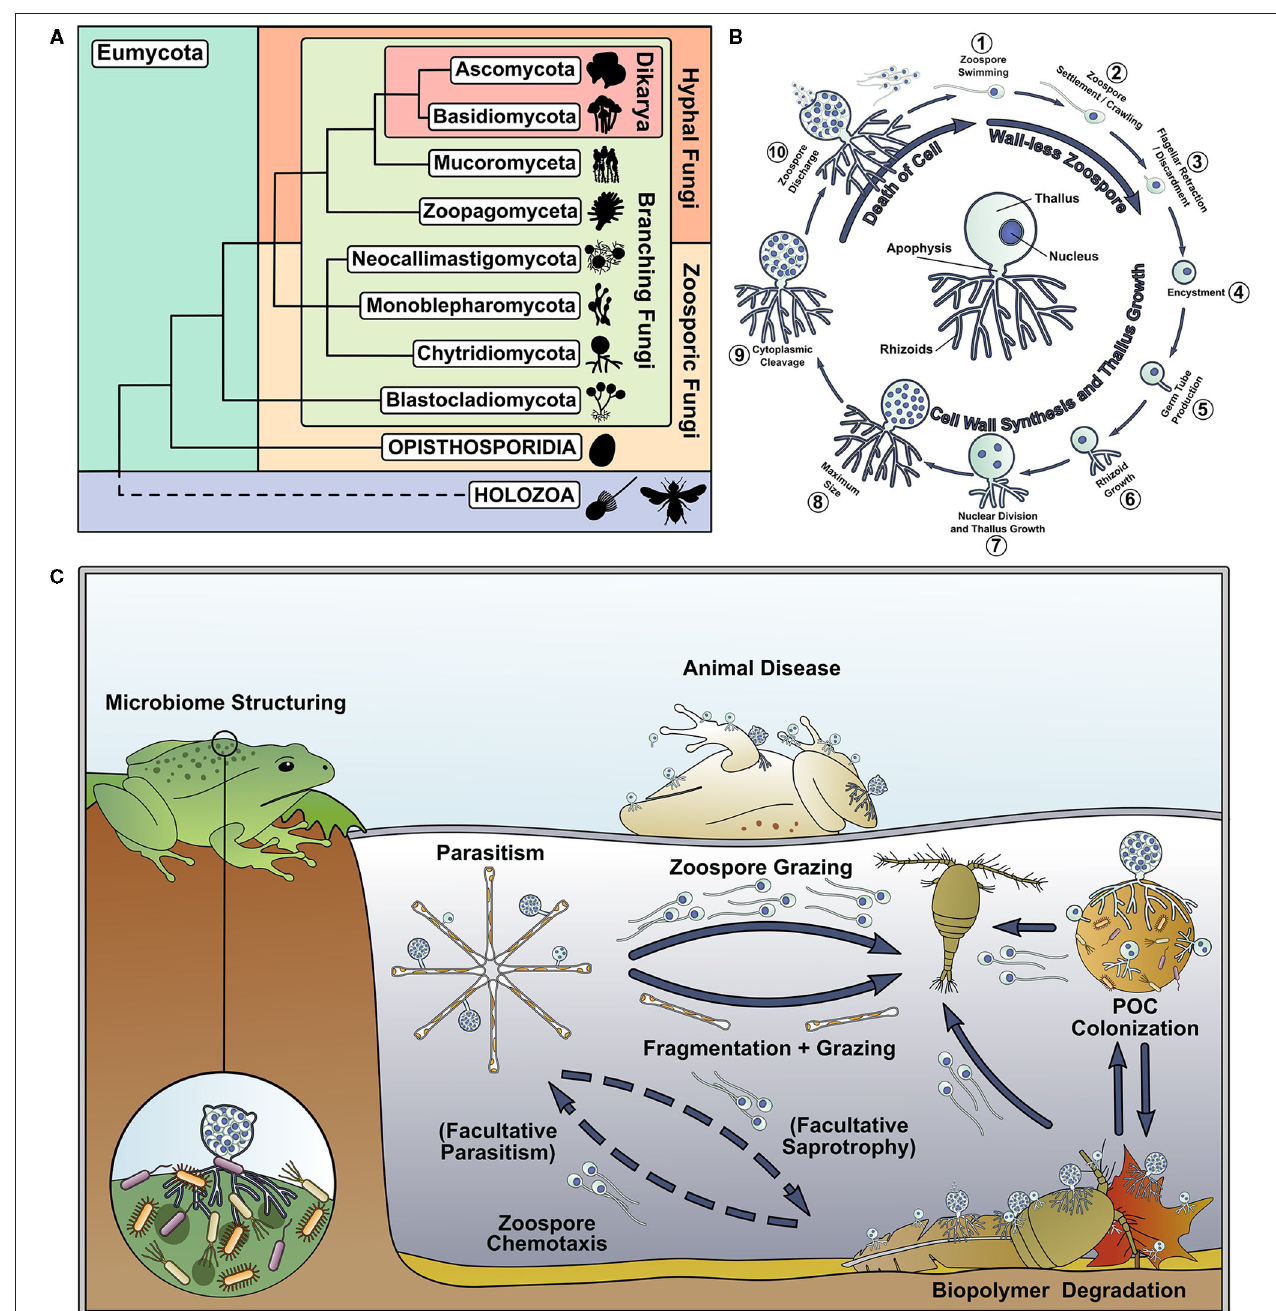
FIGURE 1 | Chytrids represent an important and understudied early diverging branch of the fungal tree of life and are important components of aquatic food webs. (A) Phylogenetic tree of the Kingdom Fungi, adapted from the phylogeny outlined in Tedersoo et al. (2018). (B) Key stages of the archetypal dimorphic chytrid lifecycle. The center of the circle highlights key features of the chytrid cell anatomy. (C) Summary of some of the ecological roles played by chytrids in aquatic ecosystems.